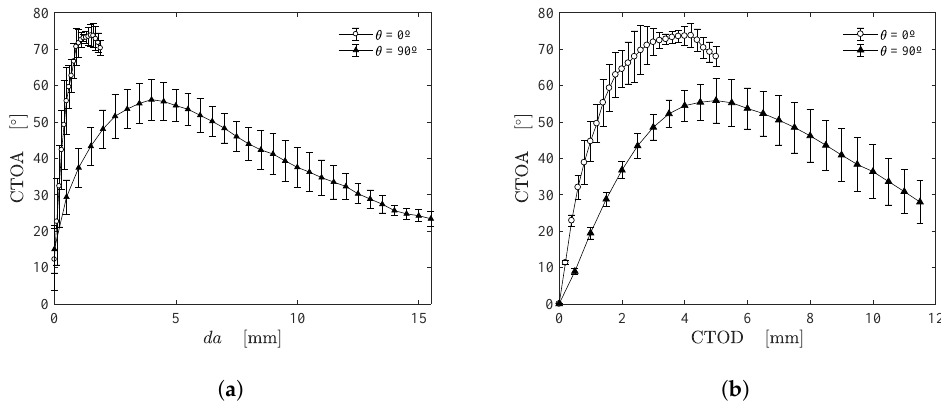
Figure 11. ( a ) CTOA as function of crack growth and ( b )